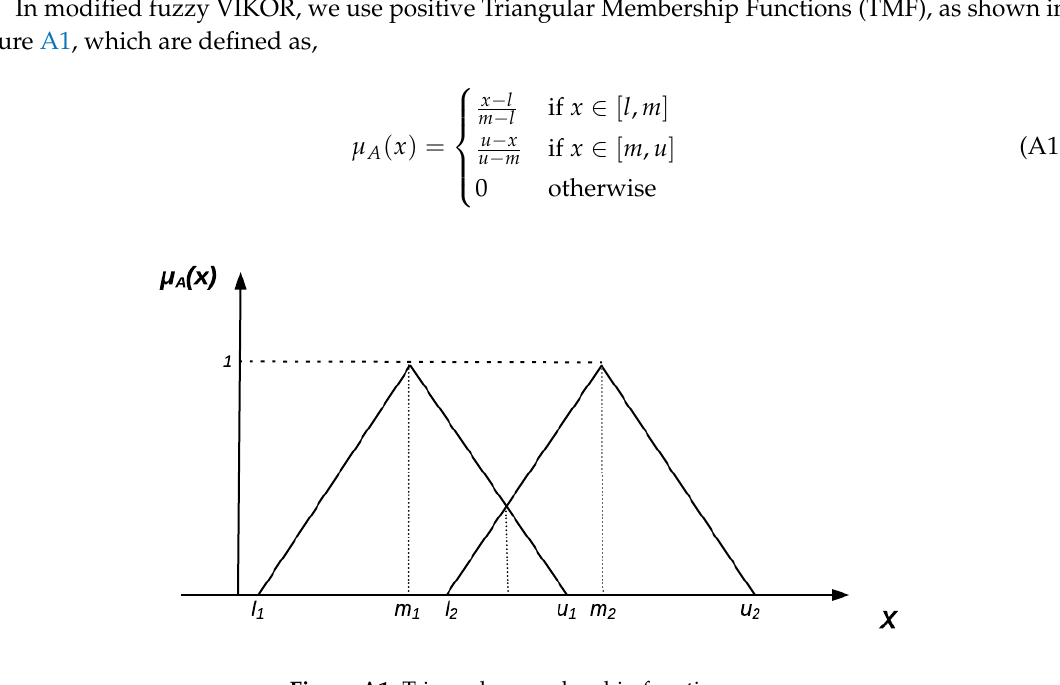
Figure A1. Triangular membership